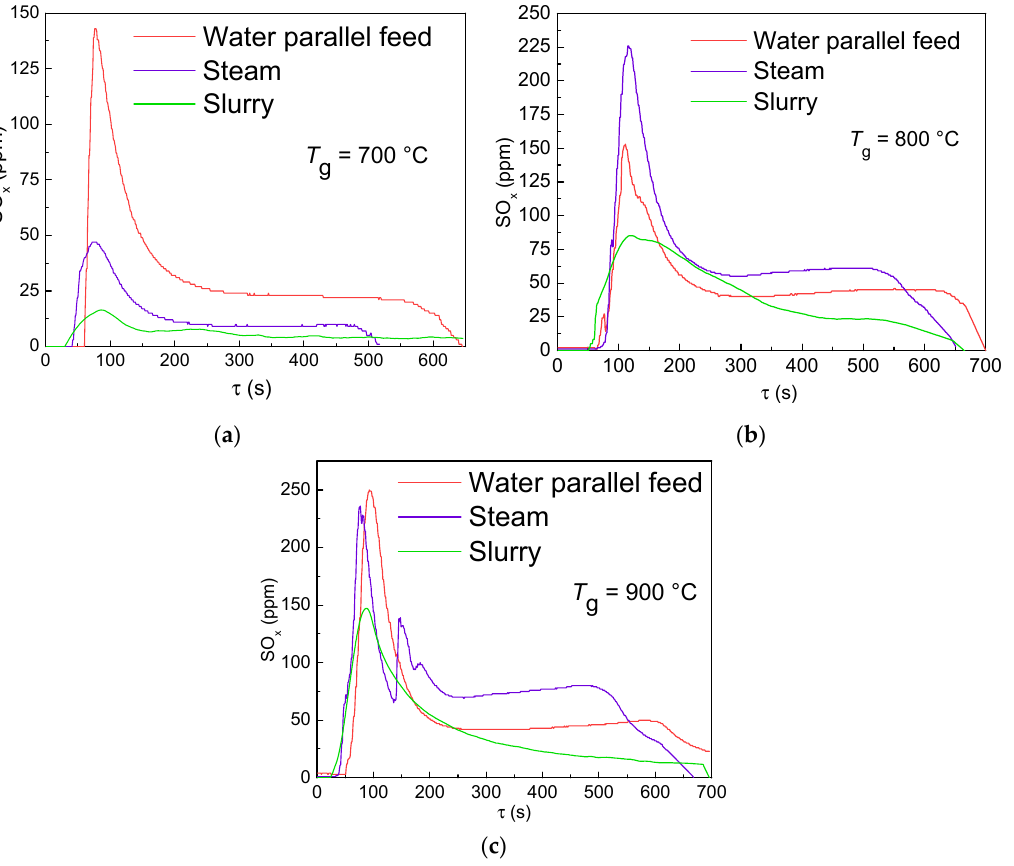
Figure 12. Average concentrations of sulfur oxide when varying the method of introducing the coal component (coal ( a ) and coal slime ( b )) and water, as well as the temperature in the combustion chamber.